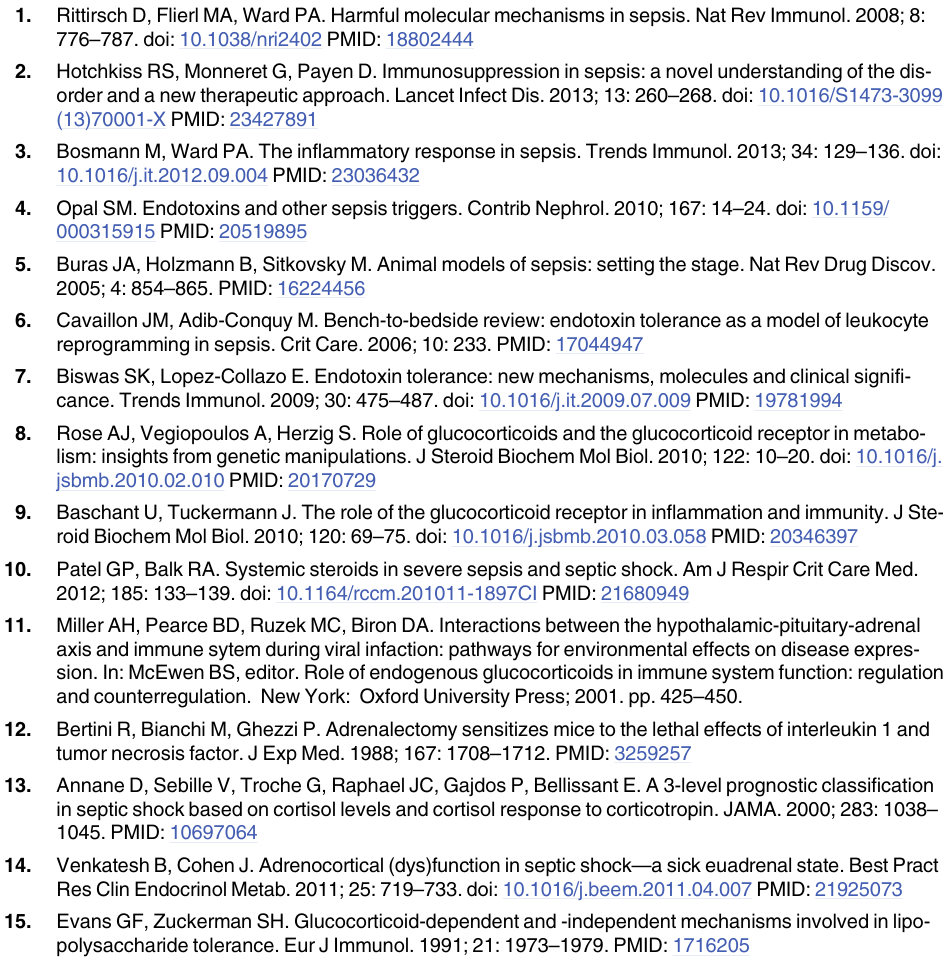
with three mice in each group. (TIF) S3 Fig. Similar activation status of freshly harvested DC in WT and GR CD11c-cre mice. Sple- nocytes were stained and gated on DC, and the activation markers CD86 and DEC205 on wild type (shaded) and GR CD11c-cre (solid line) are shown. The data is representative of three inde- pendent experiments with three to five mice in each group.